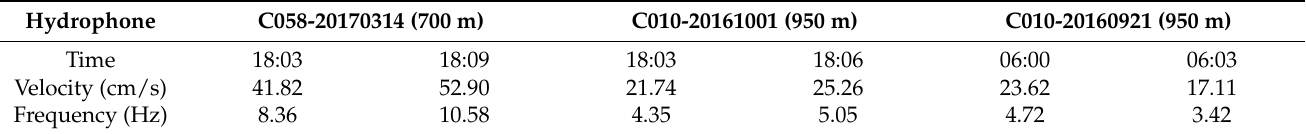
Table 3. ISW velocities and calculated frequencies of the hydrophones at different times.